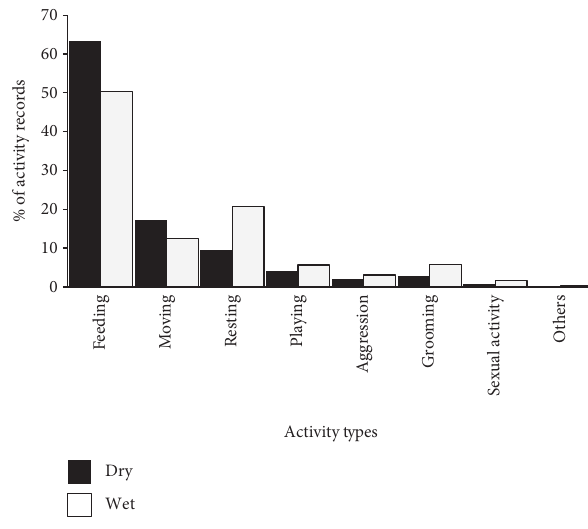
Figure 4: Seasonal activity budget of geladas. Table 1: Percentage composition of food items consumed by geladas during the wet and dry